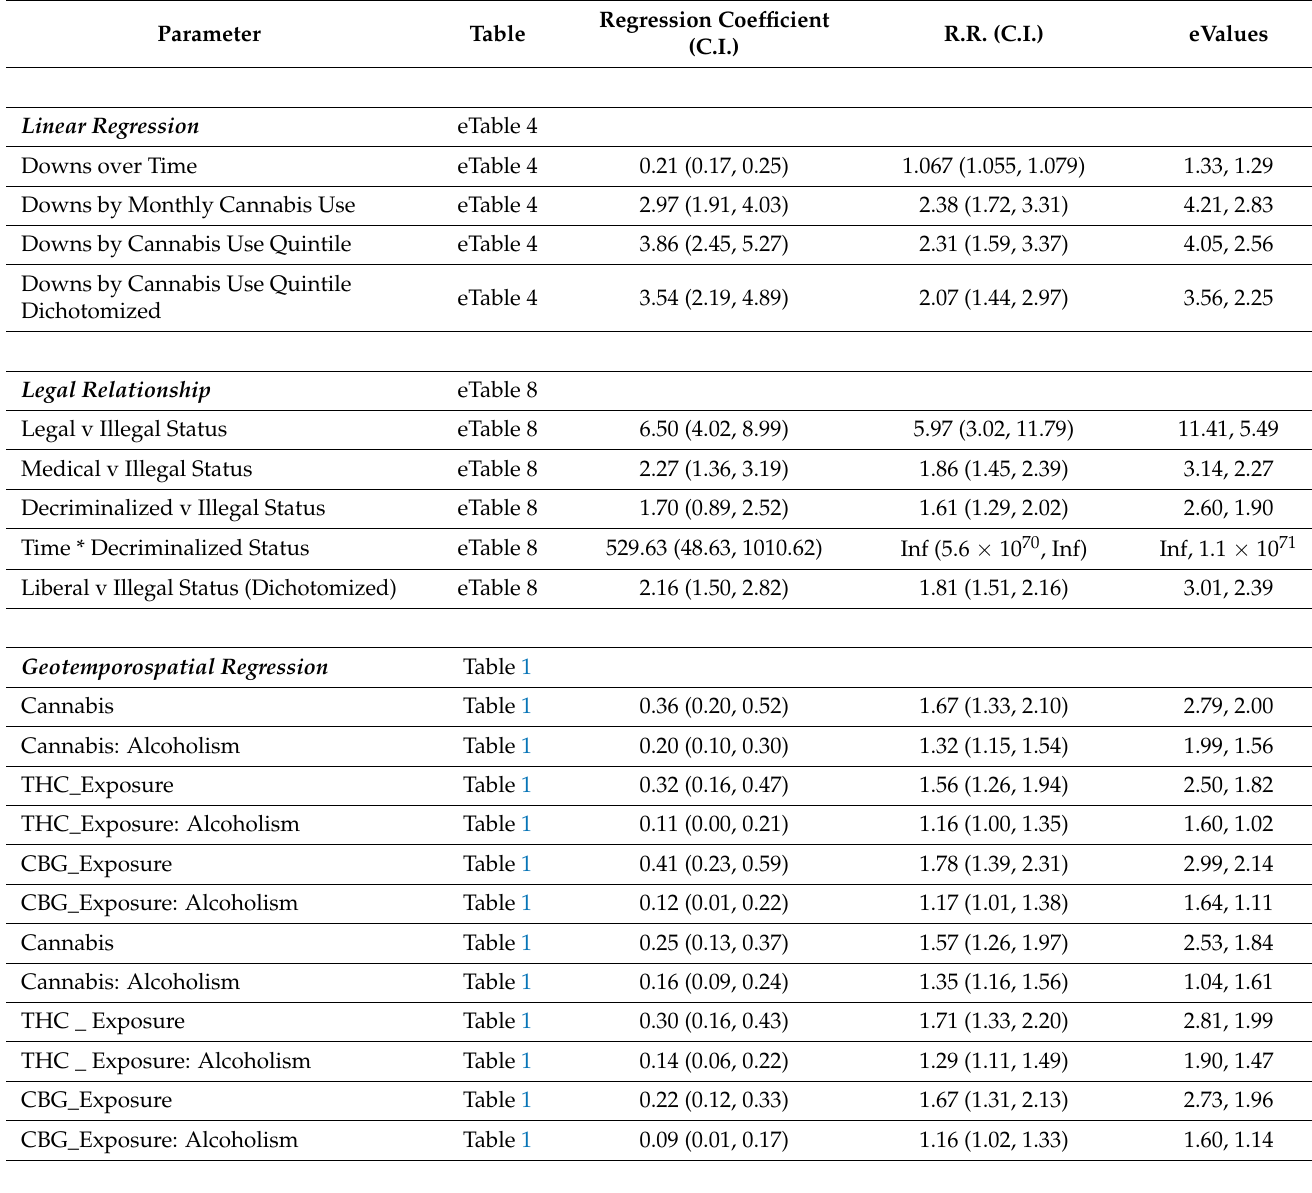
Table 5. Selected